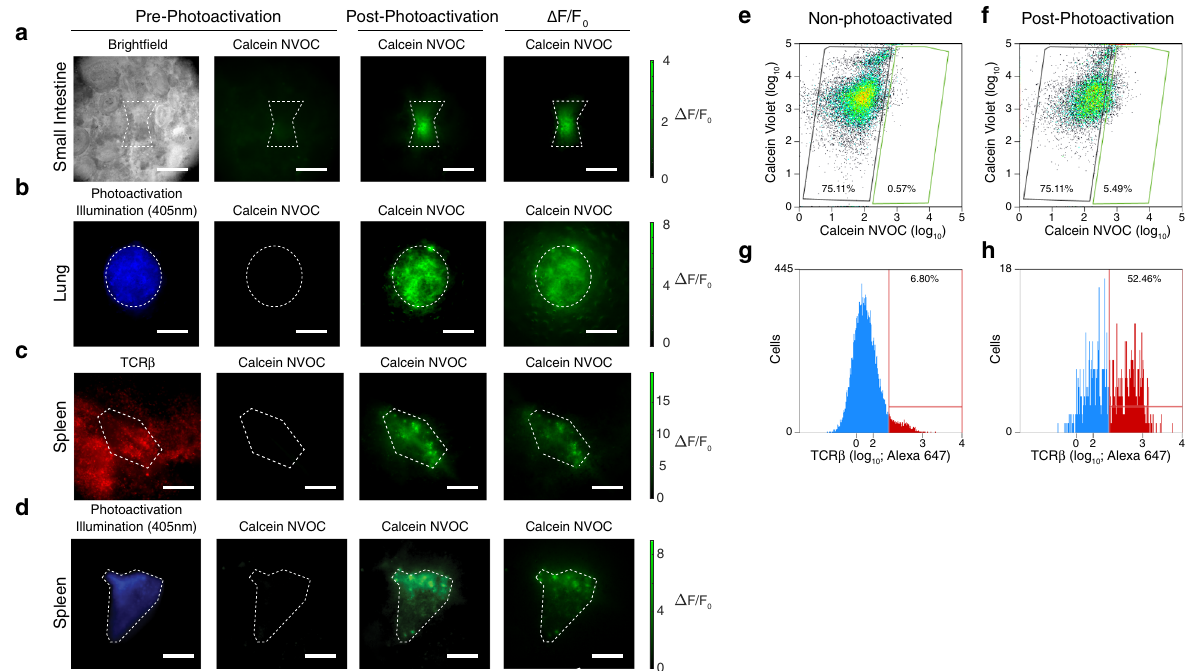
Fig. 3 SPACECAT enables tagging of precise regions in live tissue sections. a – d Various mouse tissue samples were sectioned live, stained with calcein NVOC, and photoactivated in arbitrary regions (within white dashed boundaries). a Small intestine ( n = 3 independent fi elds of view; scale bar = 50 μ m), b Lung ( n = 3 independent fi elds of view; scale bar = 50 μ m). c , d Representative images of mouse spleen ( n = 3 independent fi elds of view); T cell-rich areas were selected for photo-tagging (within dashed white boundary). Left: TCR β chain antibody (red, c ) or photoactivation illumination (blue, d ); left middle: calcein NVOC prior to photoactivation; right middle: calcein NVOC after photoactivation; right: calcein NVOC Δ F / F 0 . Scale bar = 50 μ m. e , f Flow cytometry of calcein NVOC ( x -axis, marker of viability and photoactivation) vs. calcein violet ( y -axis, marker of viability) in non-photoactivated ( e ) and photoactivated ( f ) splenic slices of T cell-rich areas. g , h Abundance of TCR β -positive cells among all splenic cells ( g ) and photoactivated cells ( h ) from photoactivated splenic